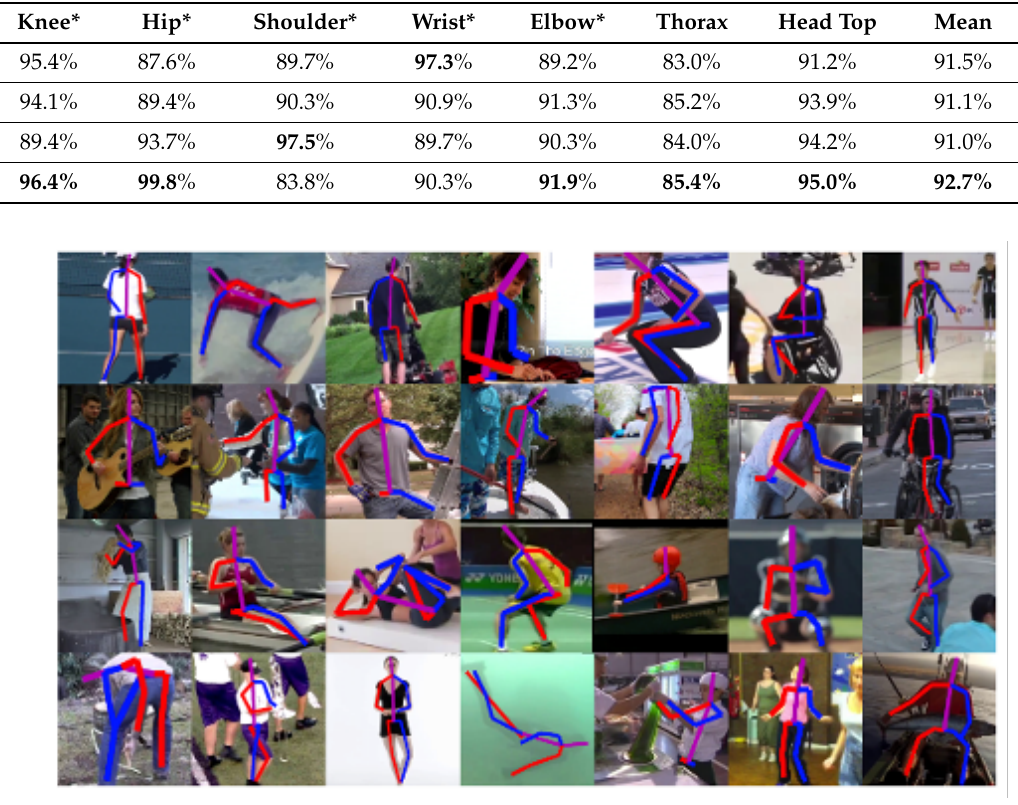
Figure 13. Experiment results on MPII of our proposed